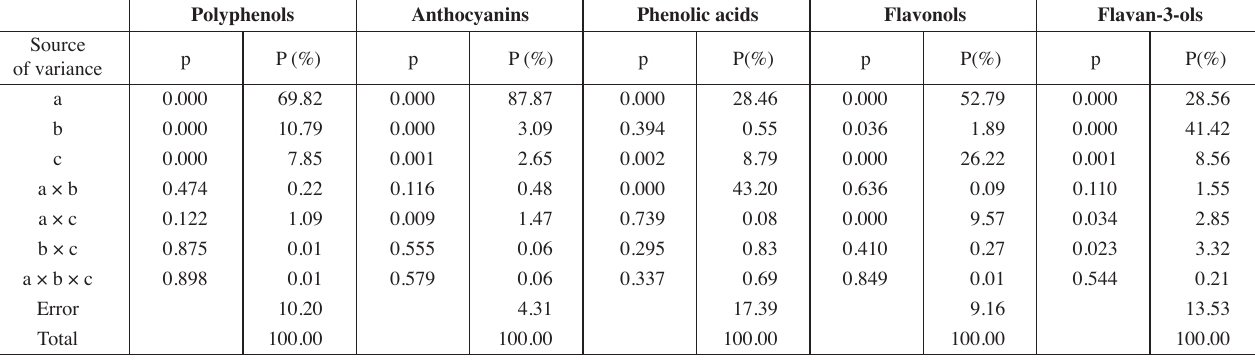
Tab. 4: ANOVA table for polyphenol content.